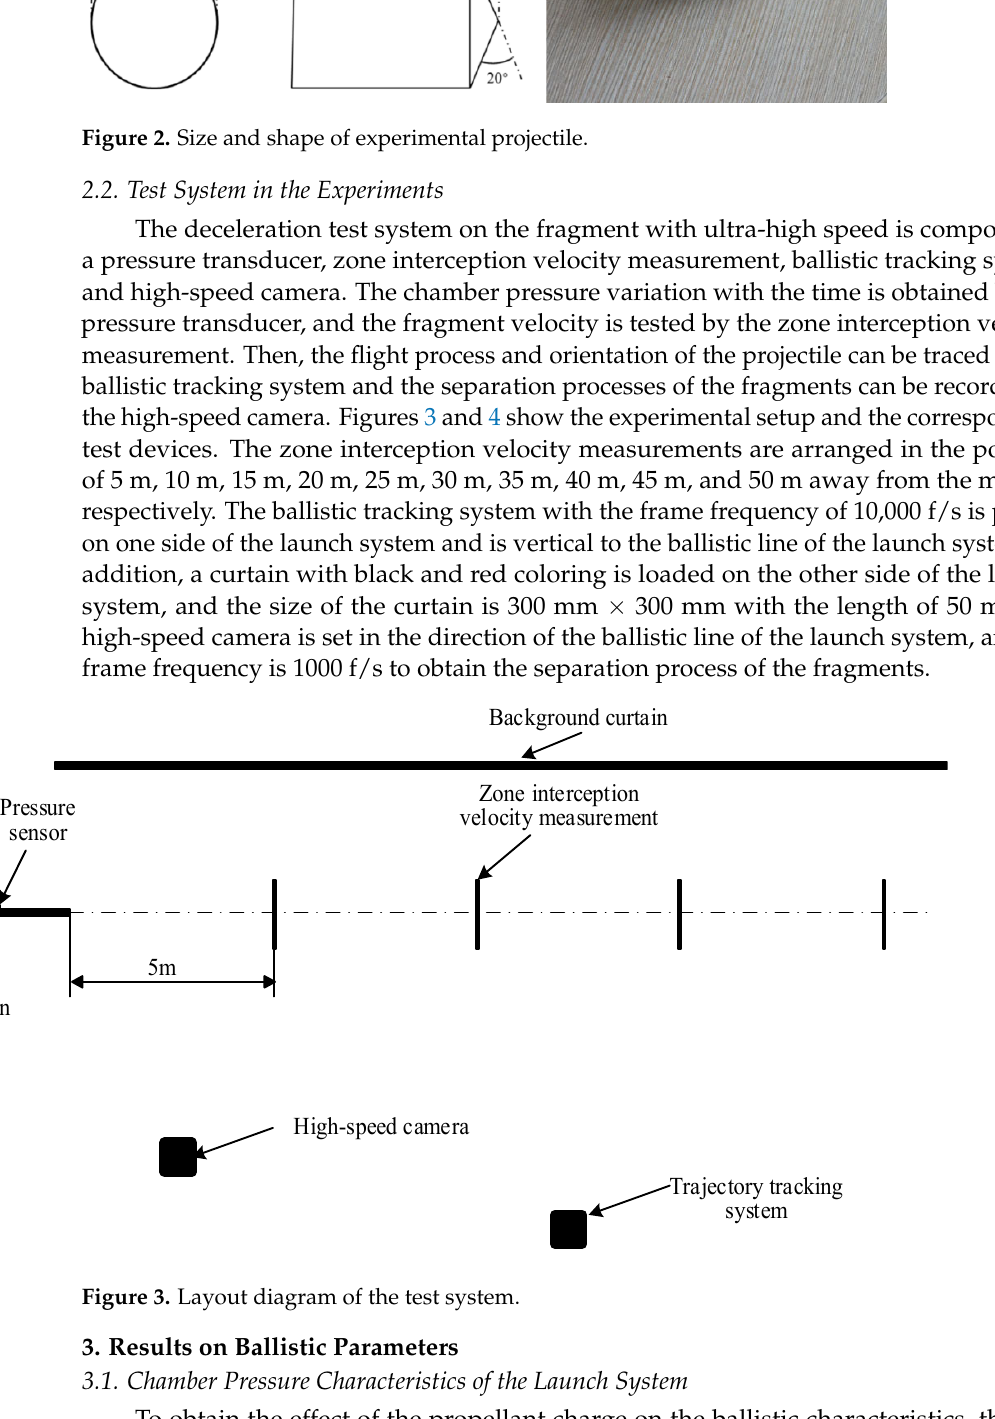
Figure 2. Size and shape of experimental projectile.